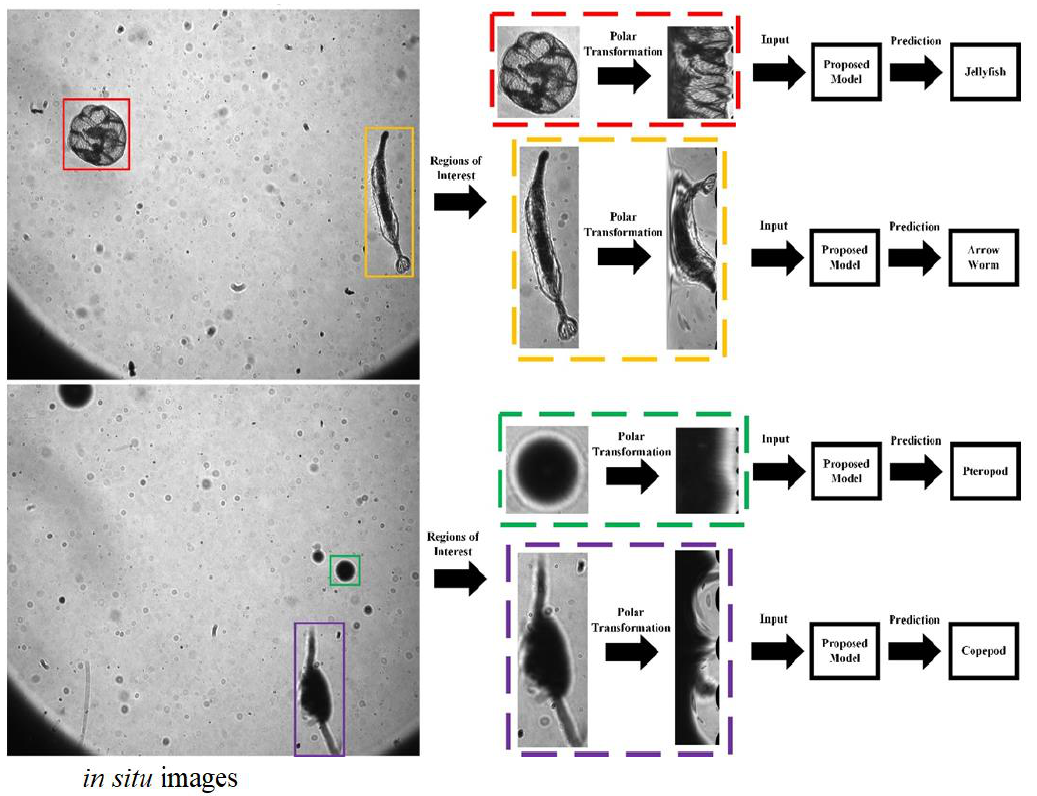
Figure 8. Application of the proposed method.